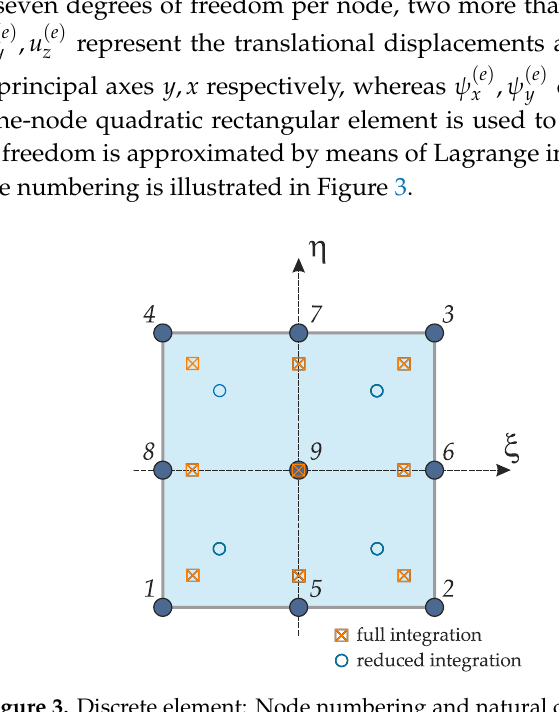
Figure 3. Discrete element: Node numbering and natural coordinates.